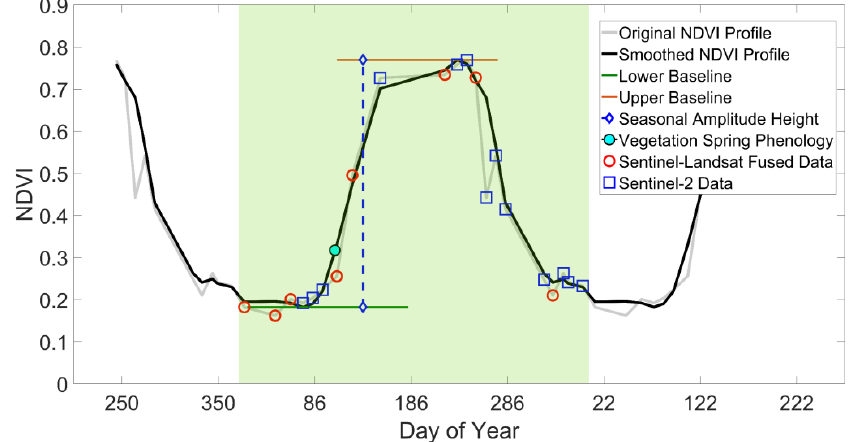
Figure 5. Diagram of extracting vegetation spring phenology from NDVI profile by TIMESAT.